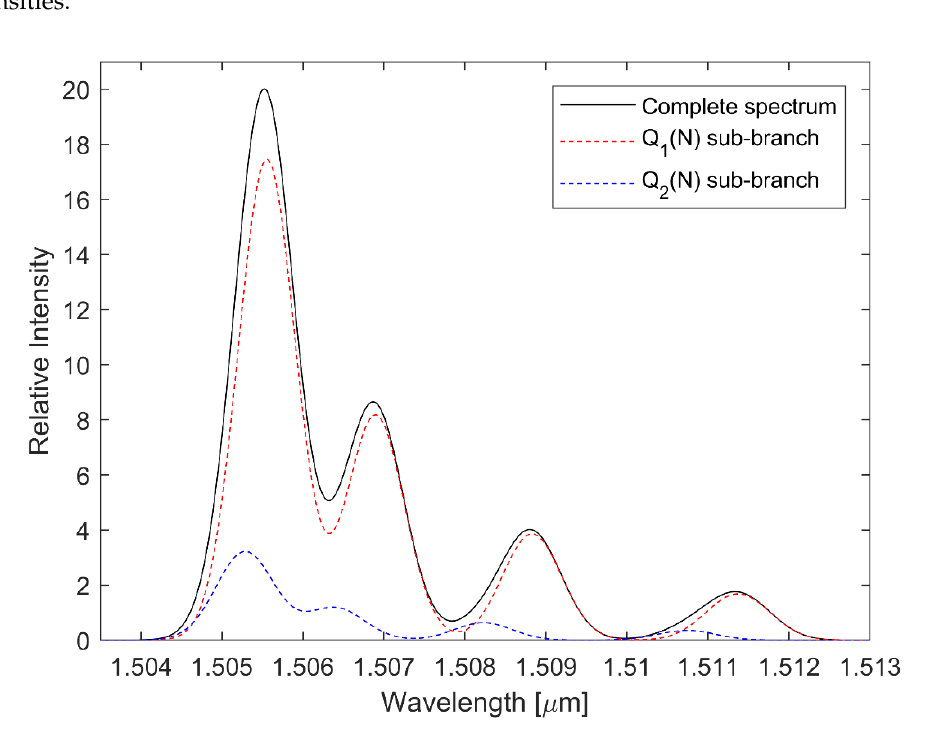
Figure 2. Example of the decomposition of the Q-branch. All lines are synthetic data. Black shows the total spectrum of the Q-branch of the (3,1) transition with a rotational temperature of 200 K and line widths commensurate with the instrumental resolution. The dashed red line shows the contribution from the Q 1 (N) lines. The dashed blue line shows the contribution from the Q 2 (N) sub-branch.